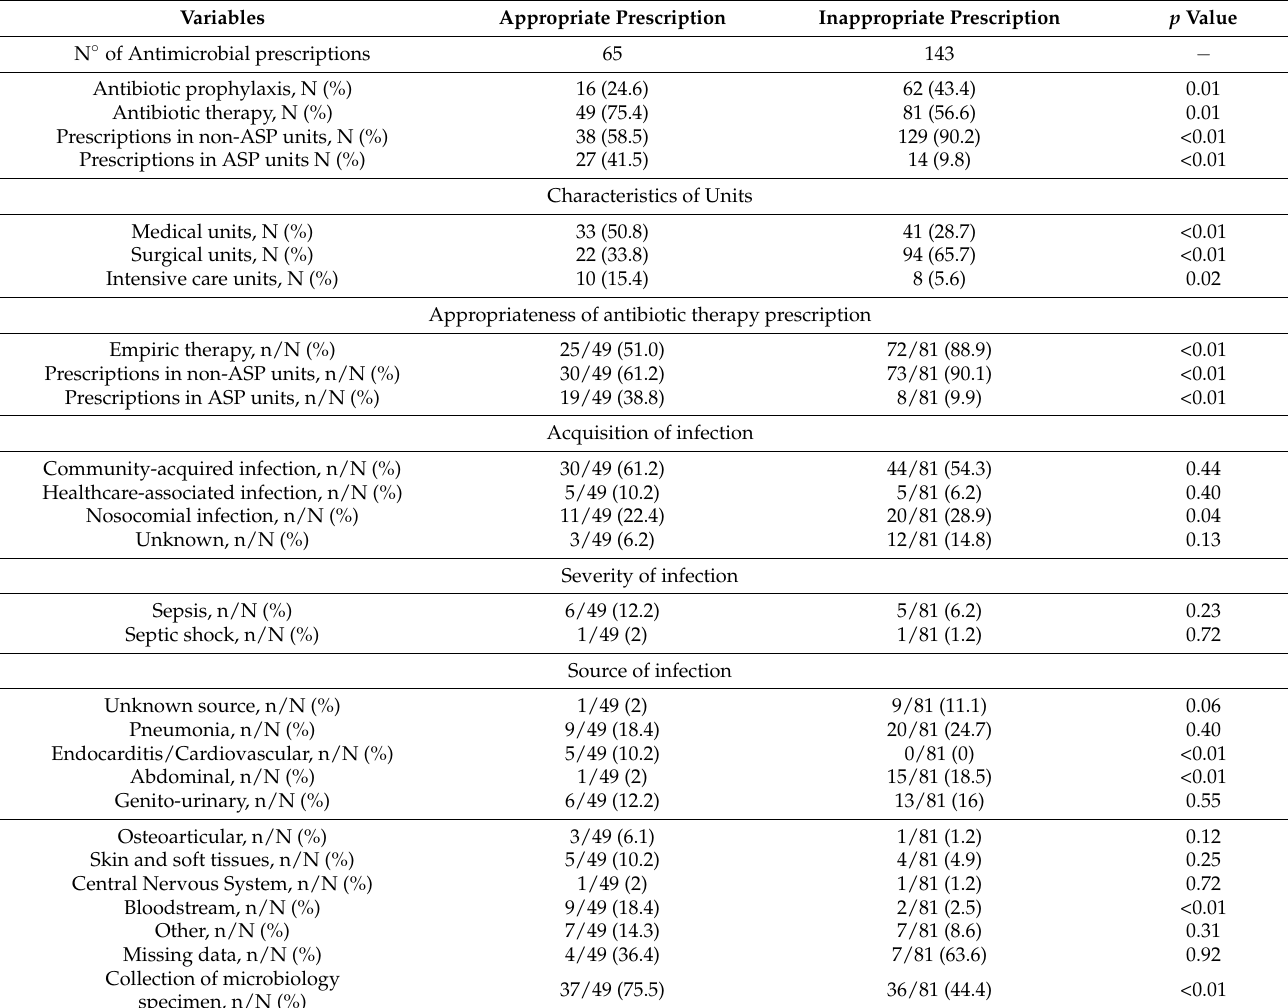
Table 2. Factors associated with appropriate or inappropriate